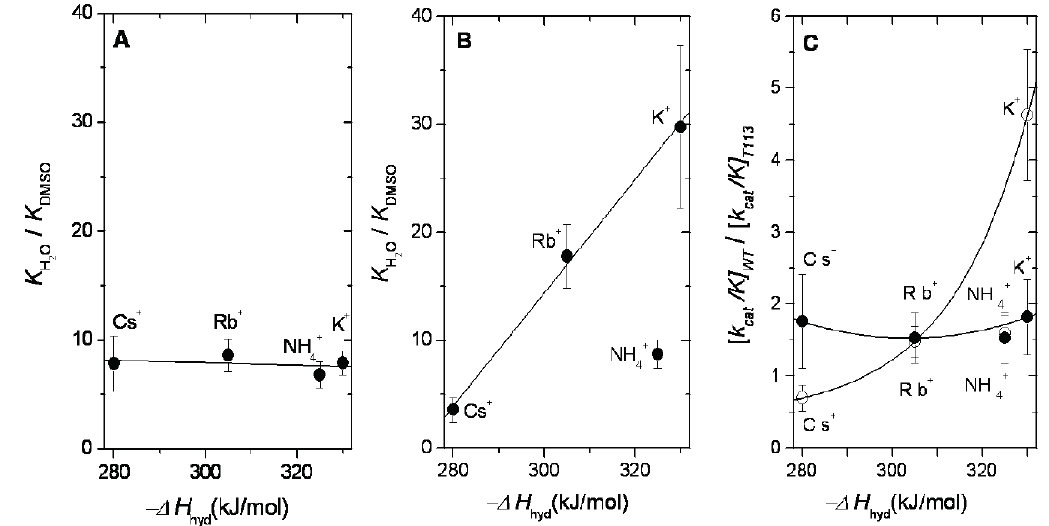
Figure 4. Ratios of K of the indicated monovalent cations in water and in 20% DMSO media versus their heats of dehydration for WT-RMPK ( A ) and for T113L-RMPK ( B ); In ( C ), the ratios of specificity constants ( k cat / K ) of the indicated cations in WT-RMPK to those in T113L-RMPK in 100% water ( ○ ) and in 20% DMSO ( ● ) are plotted against their heats of dehydration. The ratios of K and of specificity constants ( k cat / K ) were calculated from the data shown in Tables S3 and S6. K represents K m or K 0.5 . The correlation coefficients of ( A ) and ( B ) were 0.36 and 0.99, respectively. Data in ( ○ ) and in ( ● ) were fitted to the equations y = y 0 + Ae ( x /t) and y = A + B x + C x 2 ,